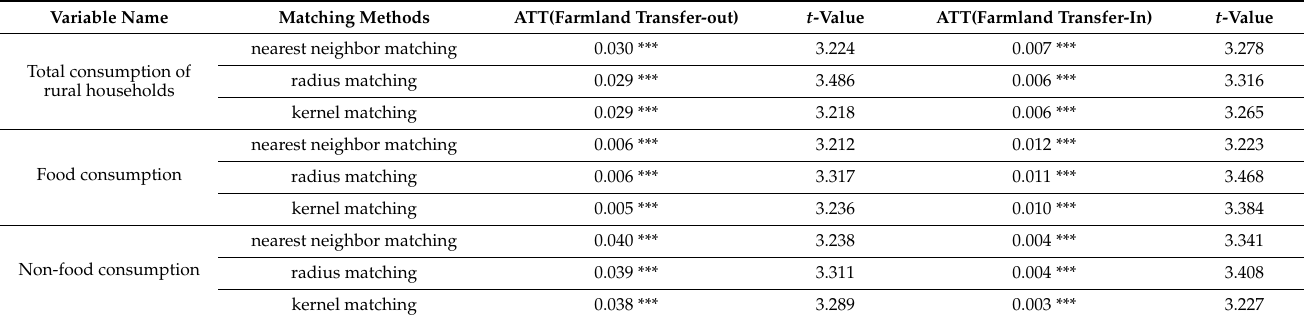
Table 6. Robustness test III: Re-estimation using PSM.